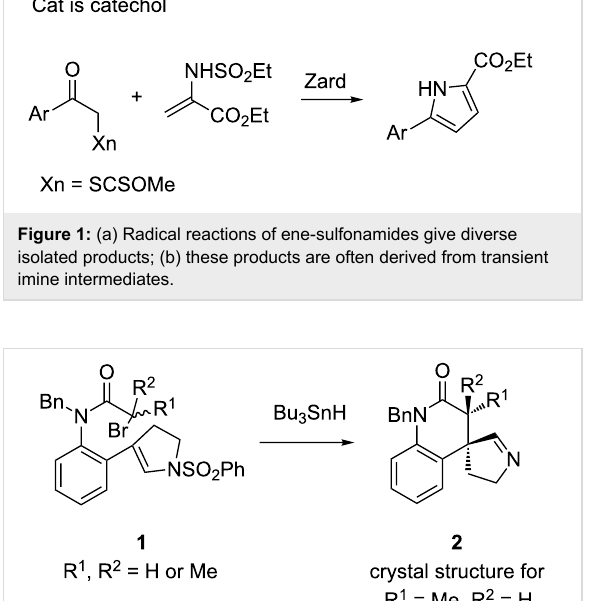
were chosen to provide imines with spirocyclic indoline and indolone substituents. We discovered that these imines are rather reactive, being either reduced or undergoing an unusual hydration and retro-Claisen-type reaction of an amide. Here we report the results of these experiments, which add to the types of products that can be formed from radical reactions of ene-